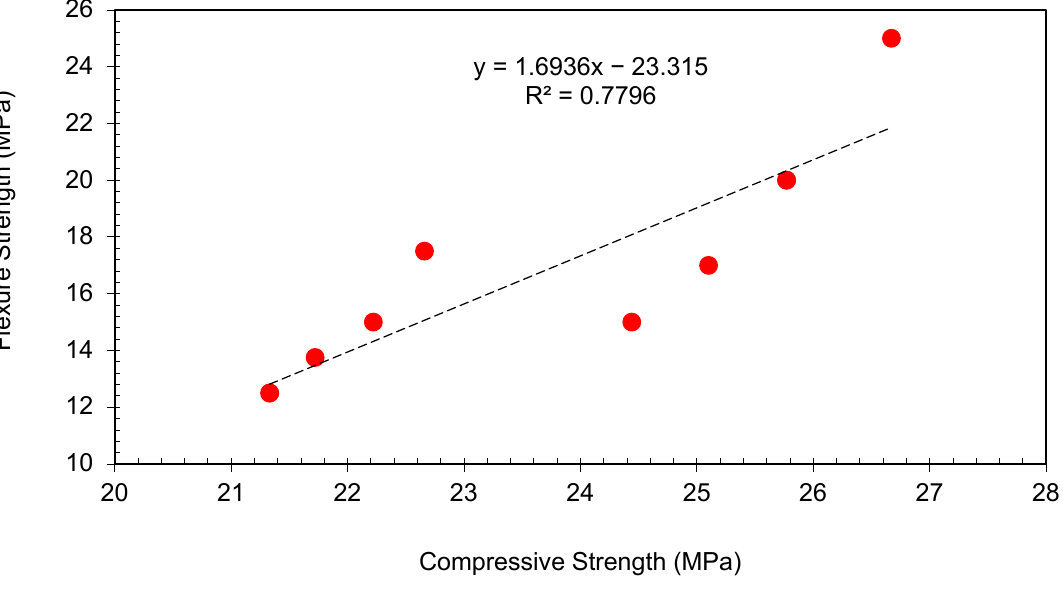
Figure 12. Correlation between compressive and flexure strength (data source [58]). Load Deflection Curve and Ductility Ratio Third point loading of 5.4 and 3.8 tons was observed at breaking of the control and BC beams, respectively, compared to design capacities of 4.1 and 4.0 tons. This fracture formed from the middle bottom region of the structure and was deflected by 3 mm. The crack width widened when the load increments were increased. Flexural fractures were observed by web shear cracks in the same direction. Ultimately, the control and BC concrete beams collapsed at 10 and 8 tons, respectively, when the loads were increased. Figure 13 displays the load versus deflection curves for the two beams for the third point loading,